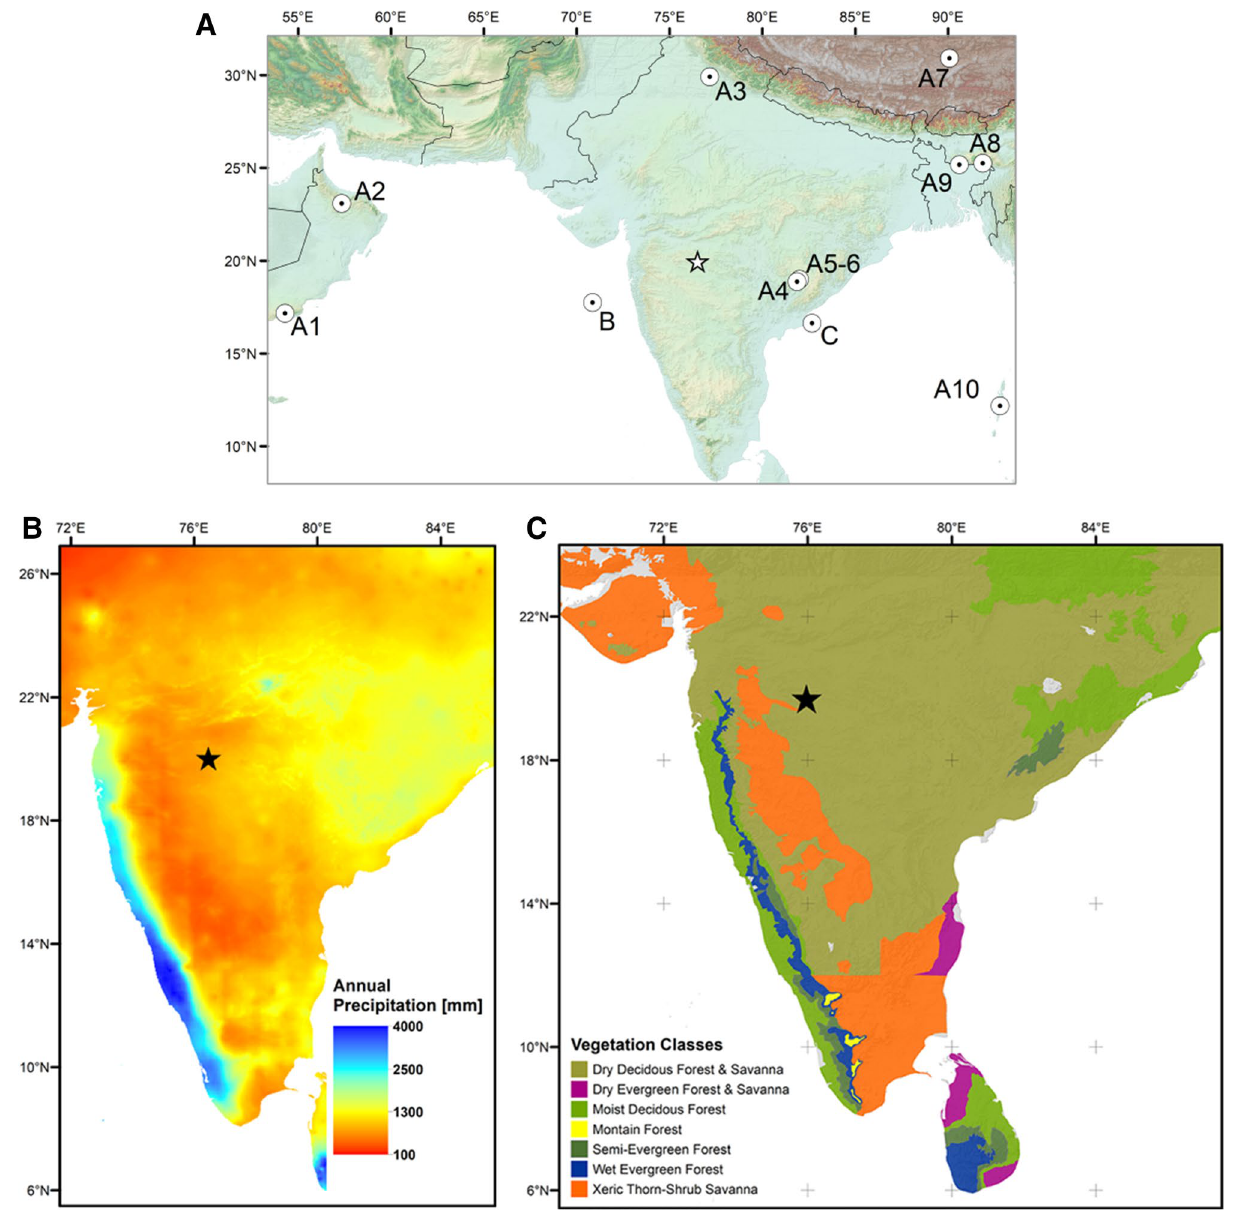
Figure 1. ( A ) Map of South Asia and the location of climate and environmental archives shown in Figs. 2 and 3. A1-10: speleothem records used to construct Fig. 2: B 36–40 . B: marine core SK-148/55 from 41 (Fig. 2: C). C: marine core NGHP-16A 42 (Fig. 3: B); Asterisk: location of the Lonar Crater Lake. ( B ) Mean annual precipitation (MAP) based on 43 , and ( C ) potential natural tropical vegetation of peninsular India modified from 44 and geo- referentiated using ArcGIS 10.7.1 (ESRI, 2019) 45